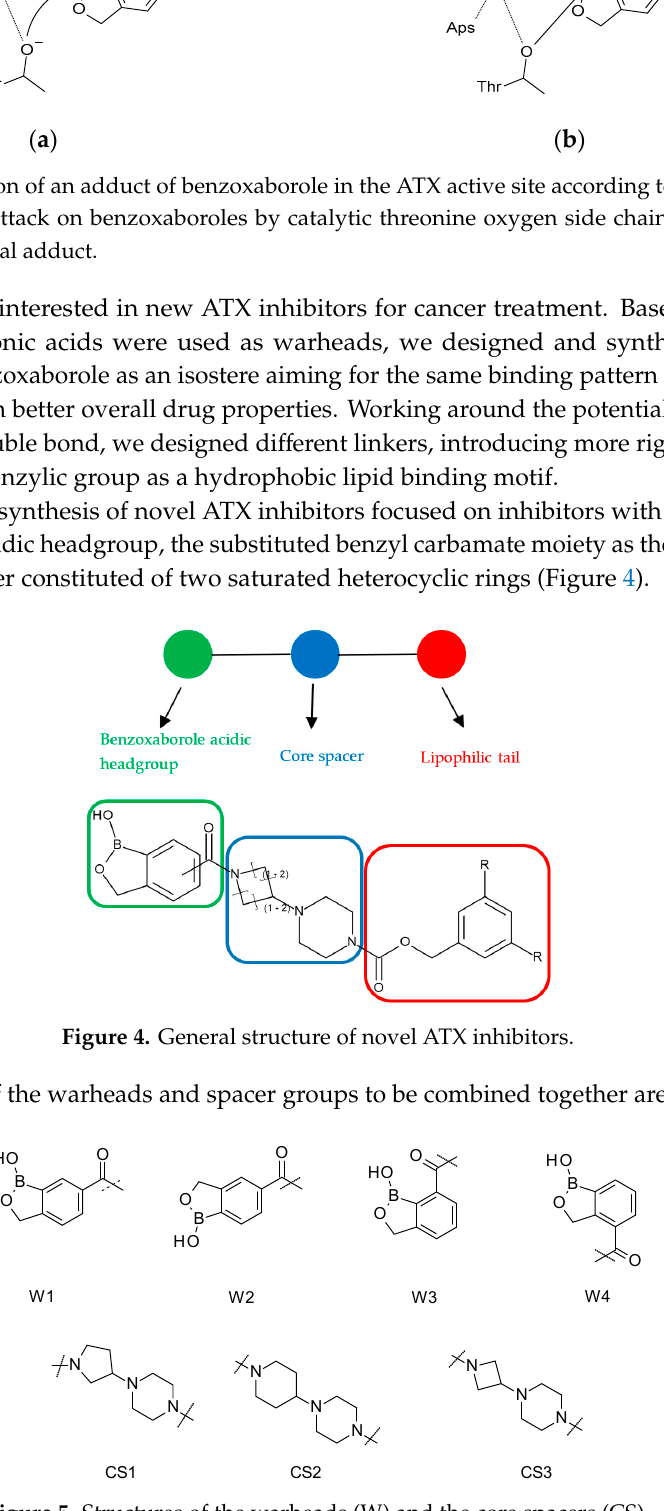
Figure 6. Overlay of HA155 boronic acid (green) inhibitor in the binding site of ATX (Protein Data Bank (PDB) ID: 2XRG [9] and re-docked pose of HA155 (magenta) using Covalent Docking v1.3. [15]. ATX inhibitors [16] (Figure 7) target the hydrophobic lipid-binding pocket in the central catalytic phosphodiesterase (PDE) domain of ATX (Figure 8A). This is located underneath a shallow groove that accommodates lysophospholipids (Figure 8B). In the active site, the first Zn 2+ ion is in the tetrahedral arrangement [17] and is coordinated by the catalytic Thr209 as well as the side chains of Asp171, Asp358, and His359. The second Zn 2+ ion coordinates with Asp311, His315 and His474, and, usually, a solvent molecule or counter-ion. Furthermore, an open tunnel (or ‘channel’; Figure 6C), which is partially hydrophobic in nature, is located in close proximity where a variety of molecules can be accommodated, forming a ‘T-intersection’ with the shallow groove [18,19] In our hands, a standard docking protocol within Glide (with and without H-bond/metal constraints) failed to dock HA155 in the active site of ATX in the pose observed in the x-ray structure (PDB ID: 2XRG [9]) This pose has the characteristic interaction of Thr209 with the boron atom. Based on natural bond orbital (NBO) calculations [20], the existence of polar character of Thr209 and boron atom of HA155 hybridized to sp 3 character, we applied a covalent docking approach. Using covalent docking, HA155 was successfully docked in the conformation observed in the crystal structure (RMSD (heavy atoms) = 0.68 Å, Figure 6). This same approach was therefore applied to our compounds in this paper. (Figure 7).